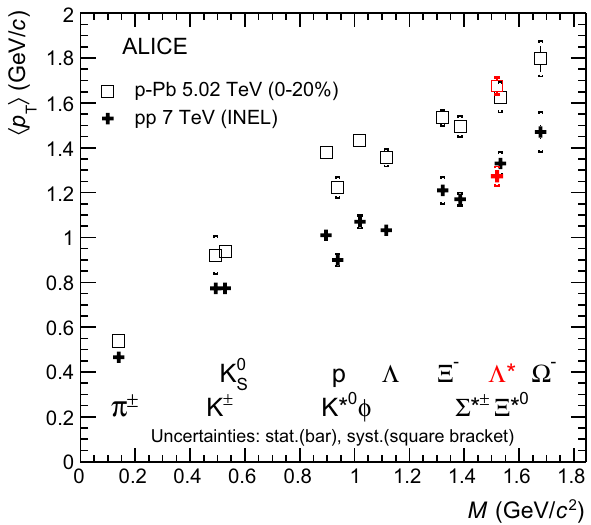
Fig. 5 Massdependenceofthe (cid:6) p T (cid:7) ofidentifiedparticlesmeasuredin √ s = 7 TeV [51,55,65] and in p–Pb collisions inelastic pp collisions at √ s NN = 5 . 02 TeV for the 0–20% multiplicity intervals [41,42,64]. at Statisticaluncertaintiesarerepresentedasbars,squarebracketsindicate total systematic uncertainties